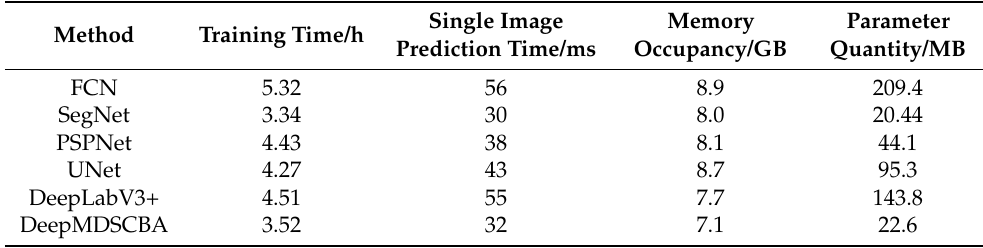
Table 7. Efficiency of different apple image segmentation